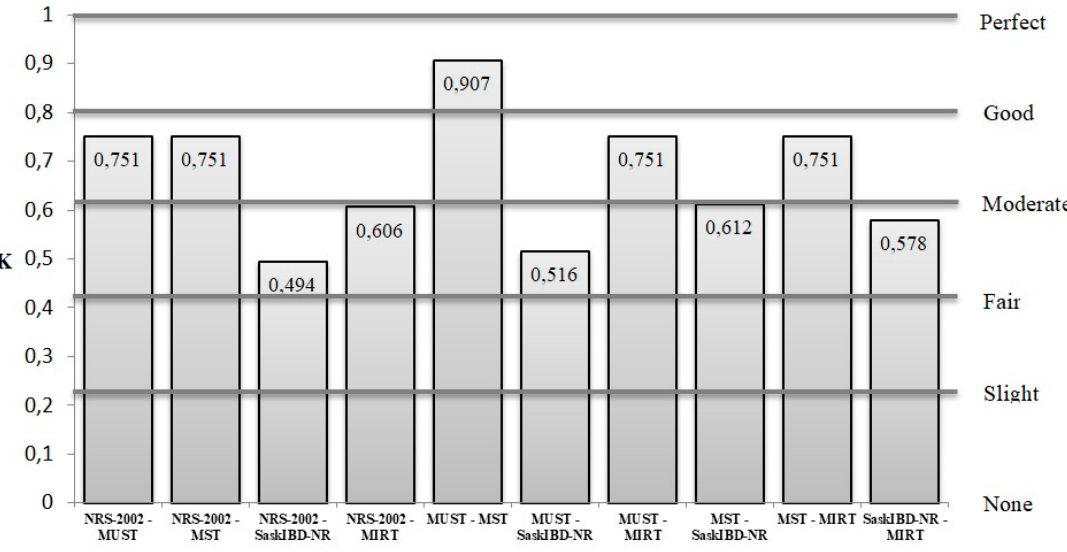
Figure 1. Concordance (K) between the nutritional screening tools.